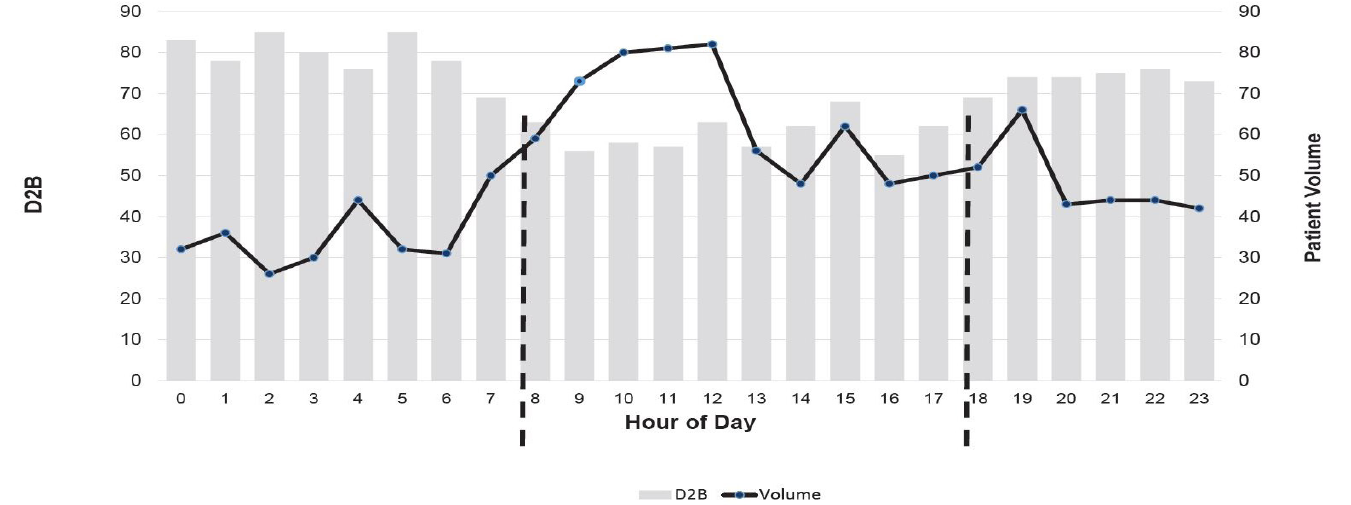
n=1,247; Psuedo R 2 =0.36,